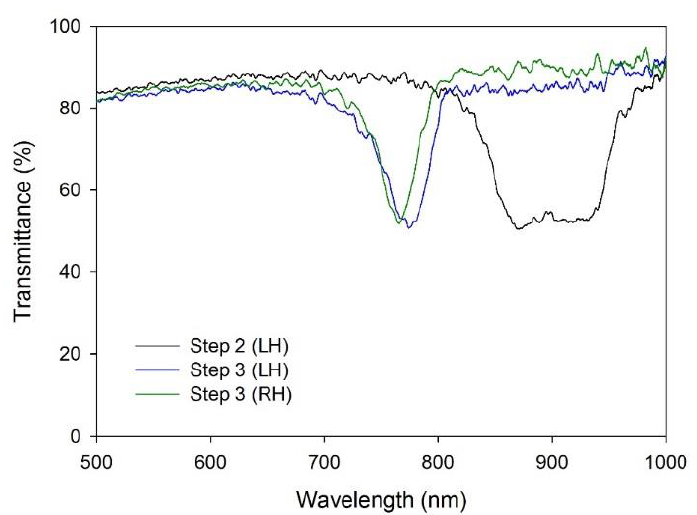
Figure 3. Transmittance spectra of the CLC prepolymer at Step 2 (after injection of the CLC prepol- ymer) (black line) and the RH (green line) and LH (blue line) CLC templates at Step 3 (after photo- polymerization of the CLC prepolymer).